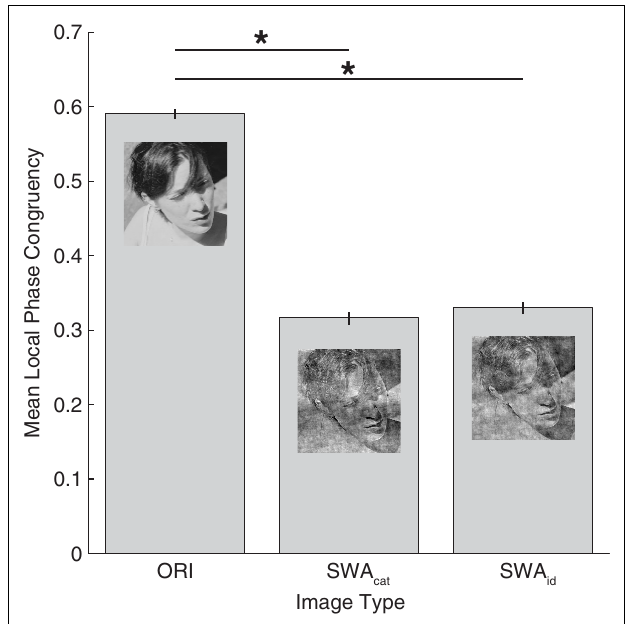
FIGURE 6 |Averaged local phase congruency (LPC) over all images as a function of the three image modifications. The function phasecong3.m (Kovesi, 2000) was applied on every image of each set (ORI, SWA cat , and SWA id ) to obtain an LPC value for each image. On an individual image, this value corresponds to the averaged value of the 10 most salient locations (as defined by the output map of the LPC on the original image, see Gaspar and Rousselet, 2009).The results show that the edge strengths are different between the three conditions ( F (2,597) = 1392.6, p < 0.001) and significantly higher in the original than in the category and identity swapped sets (test post hoc Tukey HSD).The important result here is that there is no significant difference between the category and identity swapped